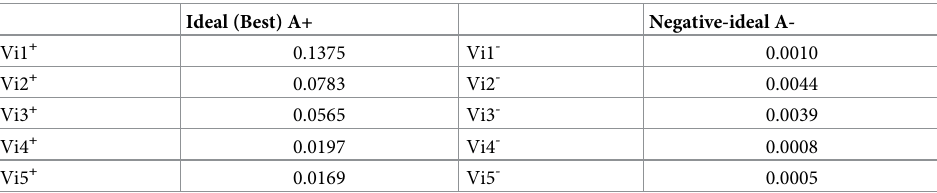
Table 4. Ideal best and negative ideal solution